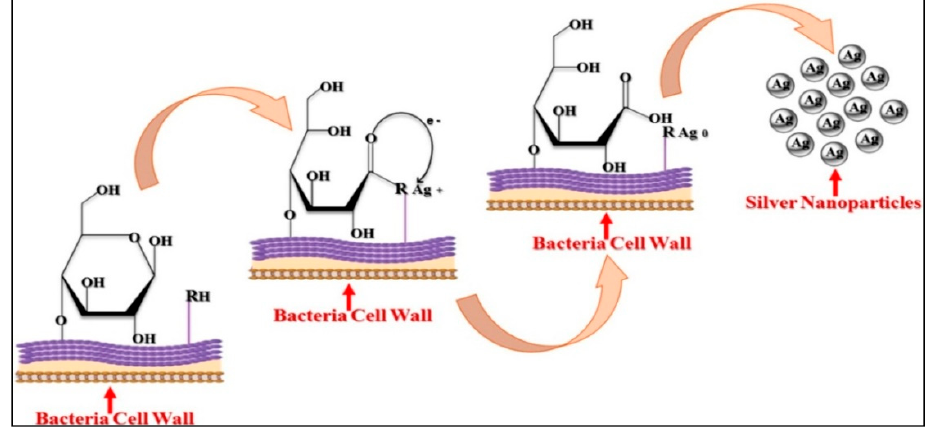
Figure 4. Non-enzymatic intracellular synthesis of AgNPs by bacteria [47].